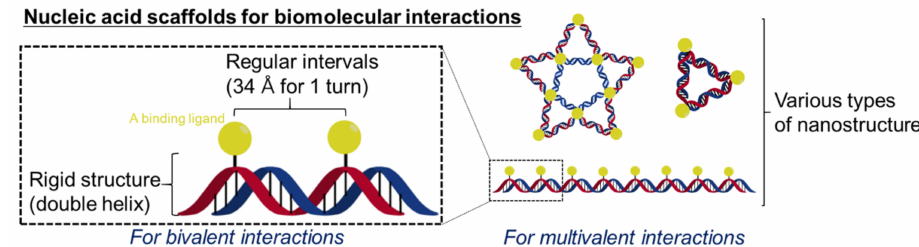
Figure 1. Advantageous features of nucleic acids for bivalent and multivalent